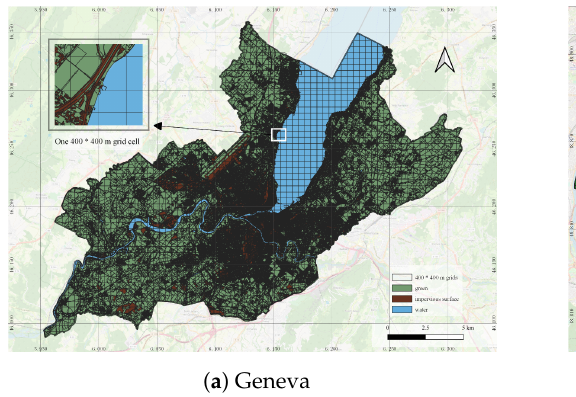
Figure 4. 400 m × 400 m